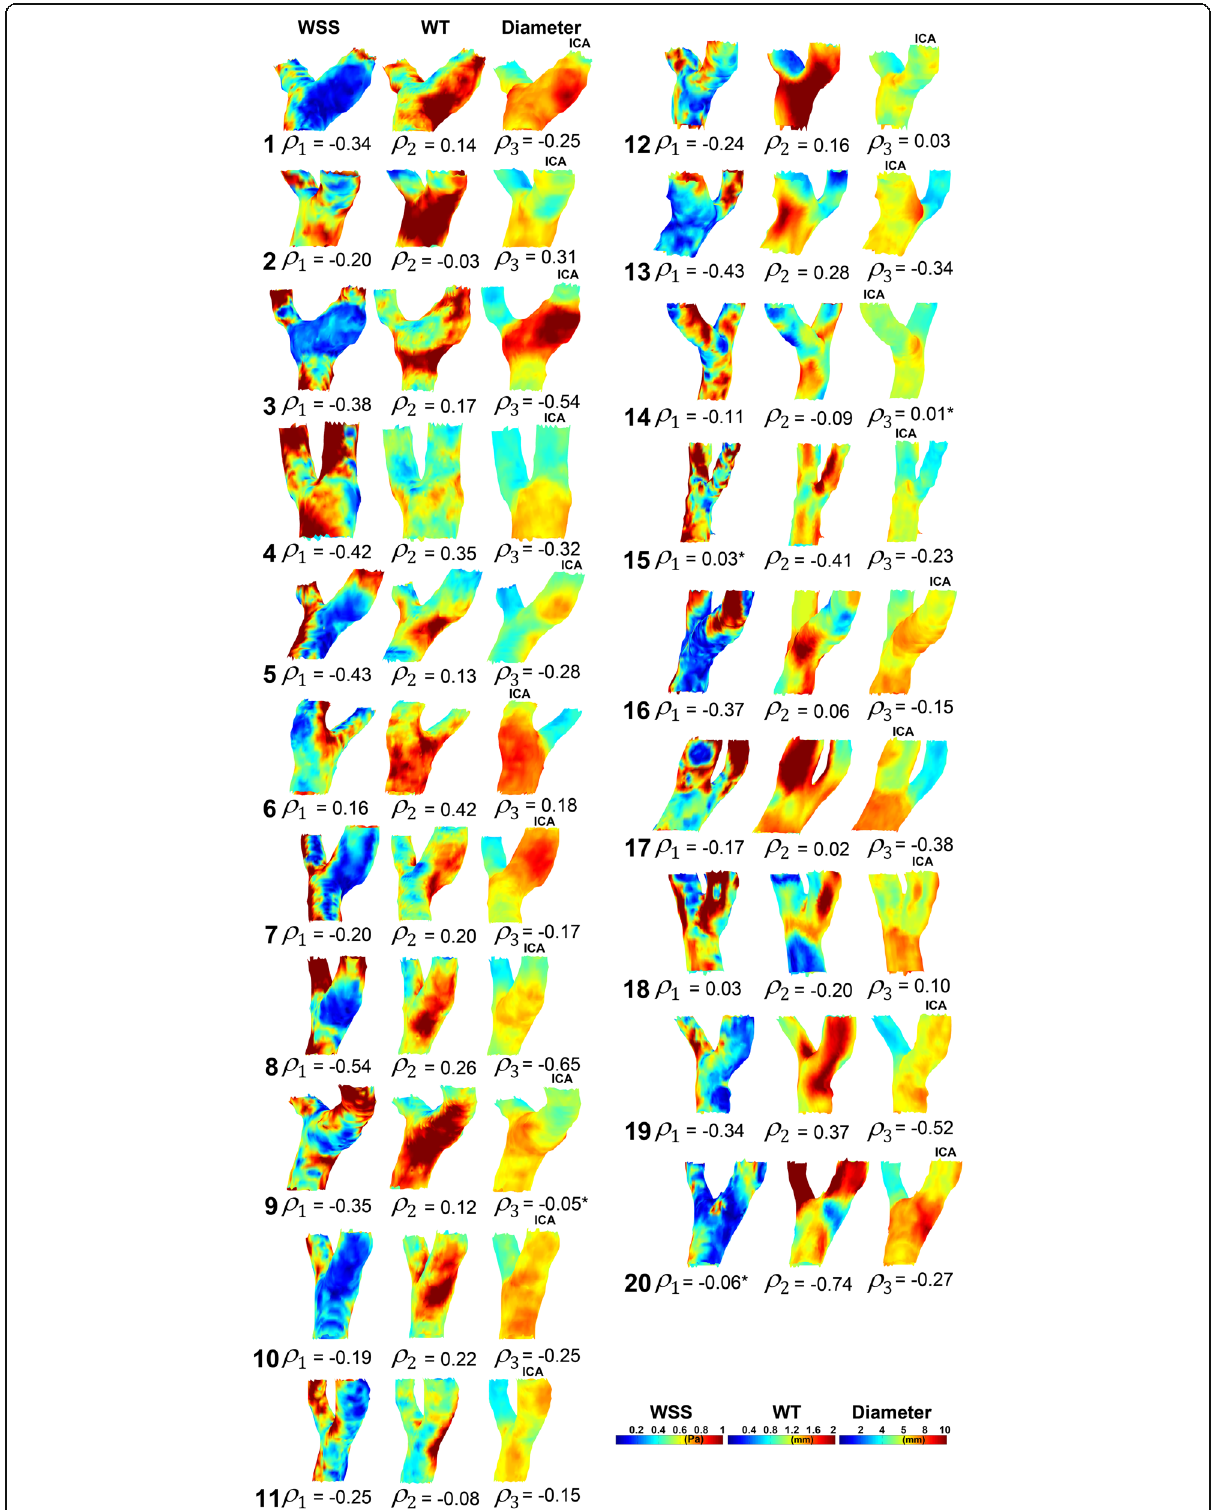
Fig. 2 Wall shear stress ( WSS ), wall thickness ( WT ) and diameter maps of the left carotid bifurcation for all subjects. The internal carotid artery ( ICA ) is indicated. Spearman ’ s ρ for WSS – WT ( ρ 1 ), WT – diameter ( ρ 2 ) and WSS – diameter ( ρ 3 ) is given. Asterisks indicate where the linear model was